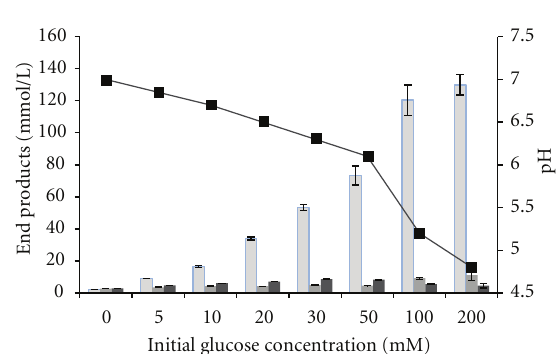
Figure 3: End product formation from di ff erent initial glucose concentrations. Also shown are percent of glucose degraded. Values represent means of two replicates and standard deviation are shown as error bars. Columns from left to right; ethanol, acetate, hydrogen. pH measered after fermentation ( (cid:2) ).